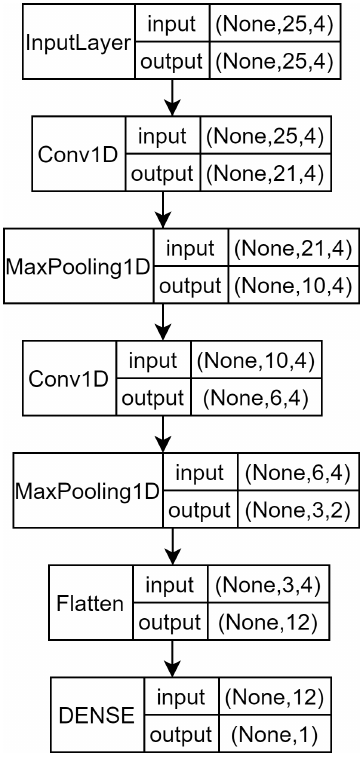
Figure A4. Gülesir’s architecture block diagram.